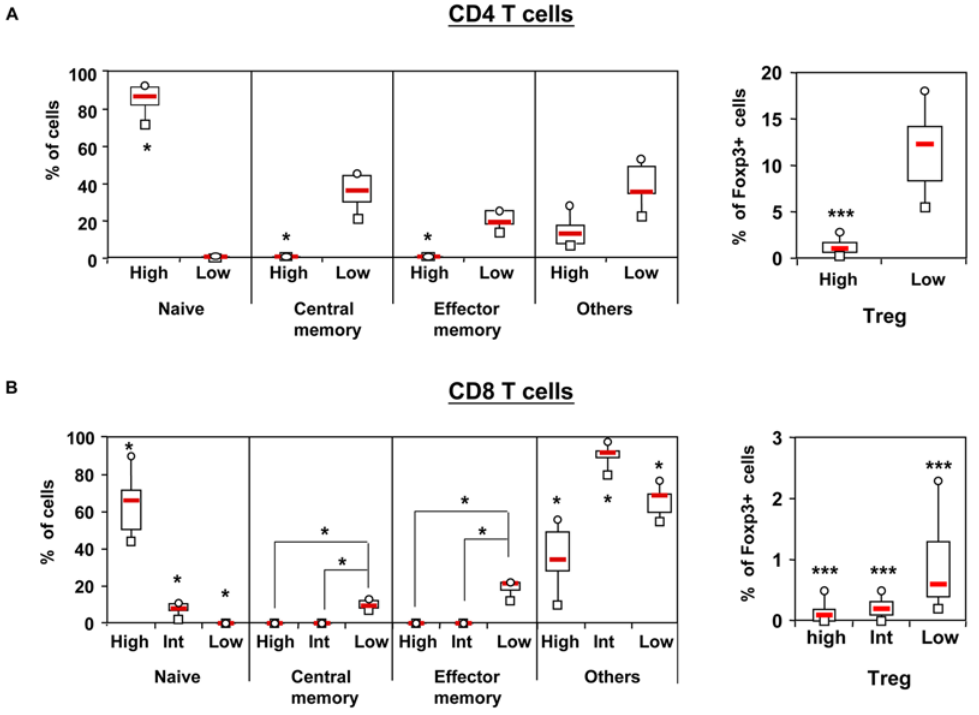
Figure 2. Phenotypic characterization of CD45RC T cell subsets. Peripheral blood leukocytes from healthy individuals were stained with mAbs against TCR, CD4 or CD8, CD45RC, CD45RA, CD45RO and CCR7 (n=6) or TCR, CD45RC, CD4 or CD8 and Foxp3 (n=27). Gates were set on CD4 T cells (upper panels) or CD8 T cells (lower panels). Box plot diagrams represent the proportion of naive (CD45RA + CD45RO 2 CCR7 + ), central memory (CD45RA 2 CD45RO + CCR7 + ), effector memory (CD45RA 2 CD45RO + CCR7 2 ) and natural regulatory T cells (Foxp3 + ) within the CD45RC subsets. The group ‘‘others’’ contains both CD45RA + CD45RO 2 CCR7 2 and CD45RA + CD45RO + subsets, subpopulations with ill defined functions. The p-values were calculated using the Wilcoxon matched-pairs test; *, p , 0.05; **, p , 0.02; p ,